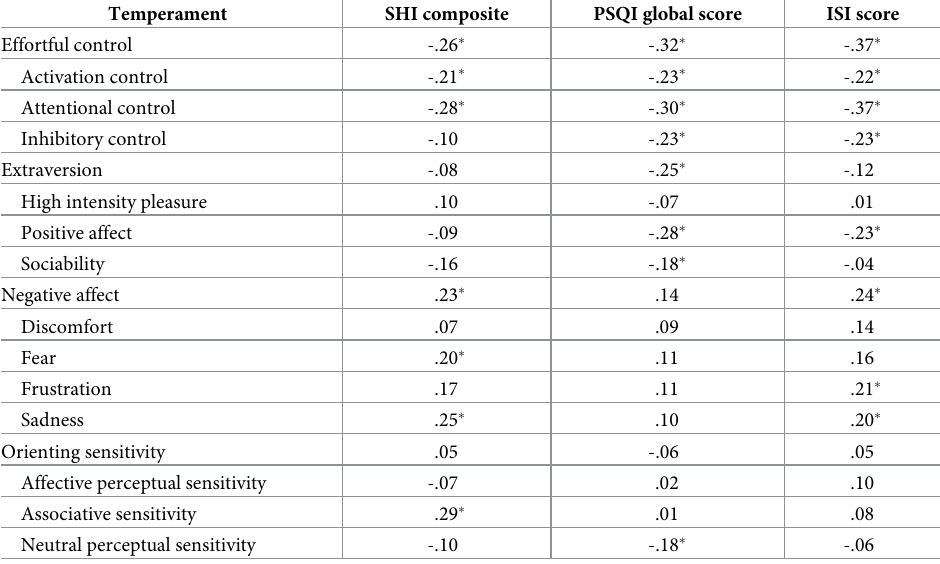
Table 3. Partial correlations between sleep variables and temperament factors and scales.